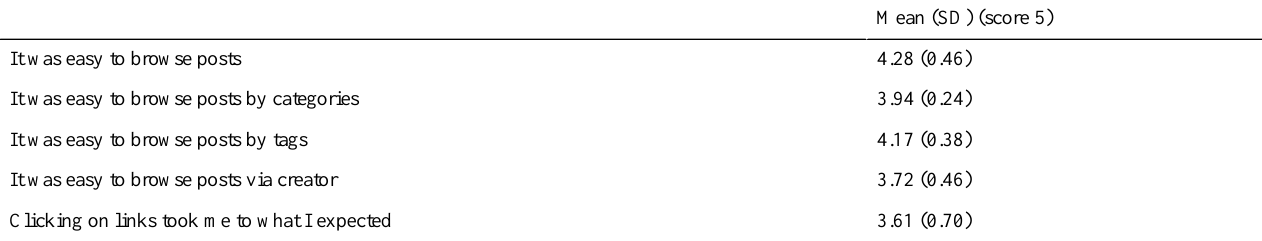
Table 6. Results of the navigation ease evaluation.